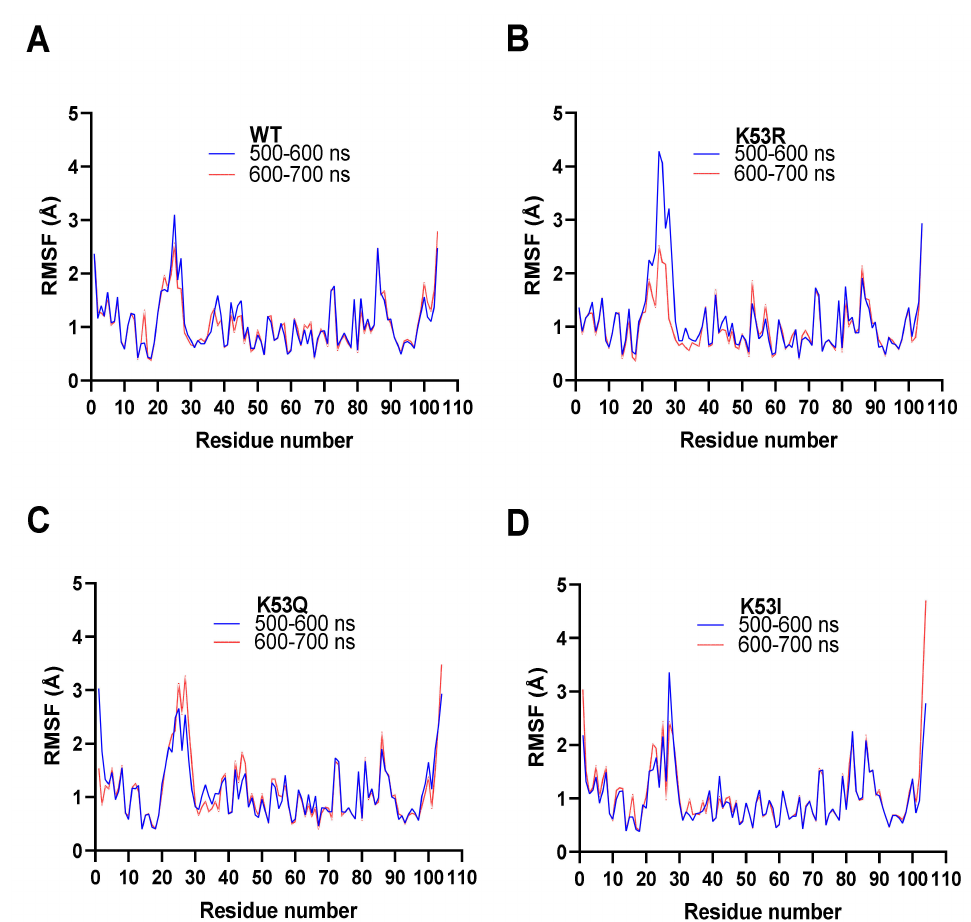
Figure 5. Molecular dynamics simulations. All four simulation averages were calculated for the 500–600 ns (blue) and 600–700 ns (red) intervals. The average RMSF (Å) for all atoms in each residue in the amino acid chains are shown. All four runs displayed equilibrium within 500 ns to 700 ns. ( A ) Molecule A from the WT Cyt c crystal structure (PDB entry 5C0Z). ( B ) Equivalent to ( A ) for K53R Cyt c . ( C ) Equivalent to ( A ) for K53Q Cyt c . ( D ) Equivalent to ( A ) for K53I Cyt c